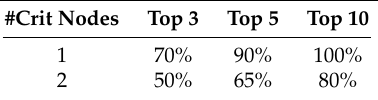
Table 4. Critical node identification success percentage when utilizing different top rank thresholds for relay and connectivity for the latency model. H = 1 is fixed.